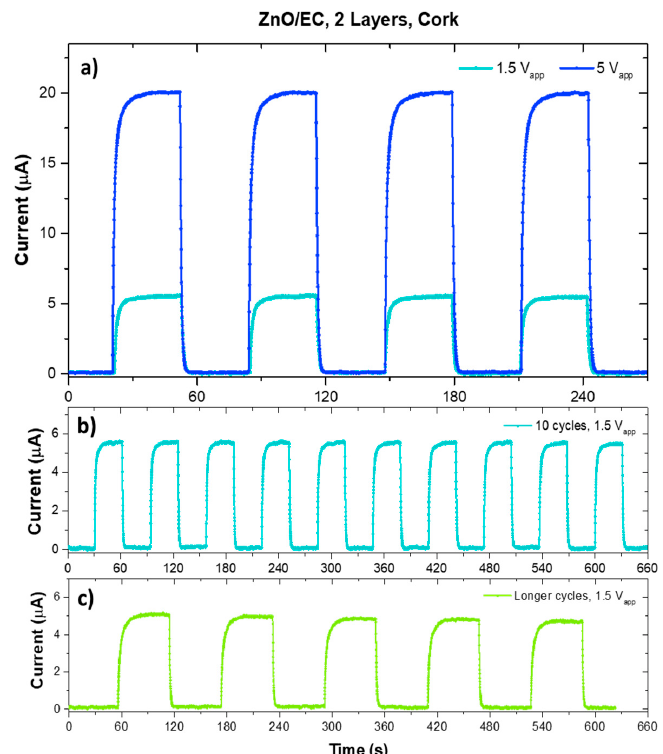
Figure 4. ( a ) Photoresponse of a cork sensor with two ZnO/EC printed layers for different applied voltages; ( b ) photoresponse of a cork sensor to 10 complete cycles ON/OFF, at a lower voltage; ( c ) photoresponse of a cork sensor to longer ON/OFF cycles.